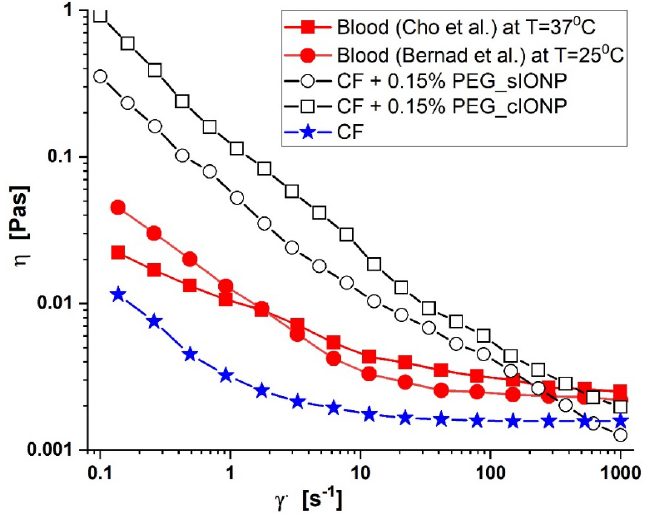
Figure 9. Viscosity curves for blood (values from the literature and a healthy volunteer) and model suspension fluid (carrier fluid + 0.15 % PEG-coated IONPs), (Cho et al. [41], Bernad et al. [42]).